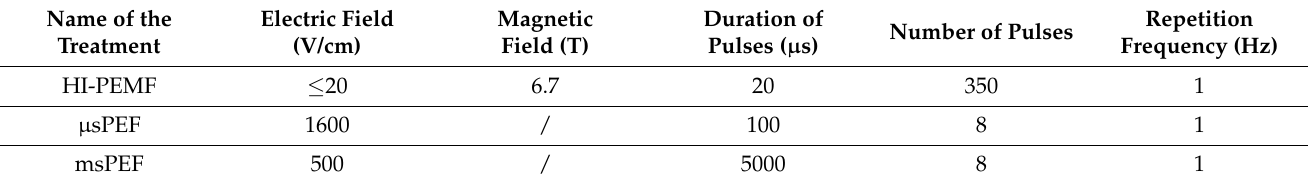
(Table 1). Still, for the evaluation of endocytosis as an uptake mechanism, we added additional pulse protocol msPEF to HI-PEMF and µ sPEF (Table 1). Table 1. Parameters of the pulse protocols used in our study. HI-PEMF and µ sPEF treatments were used to assess gene electrotransfer, while msPEF was added along with HI-PEMF and µ sPEF to assess